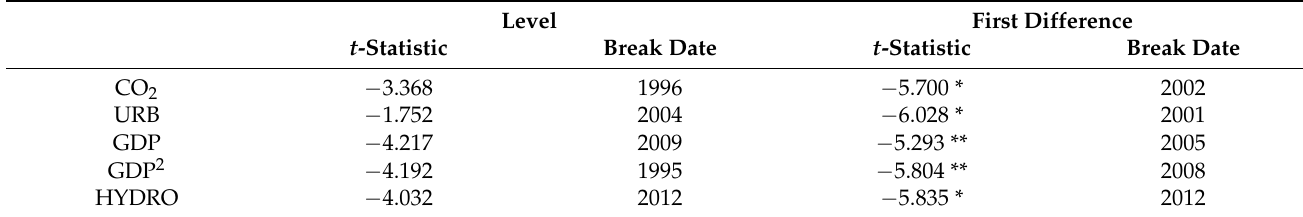
Table 1. ZA (intercept and trend).